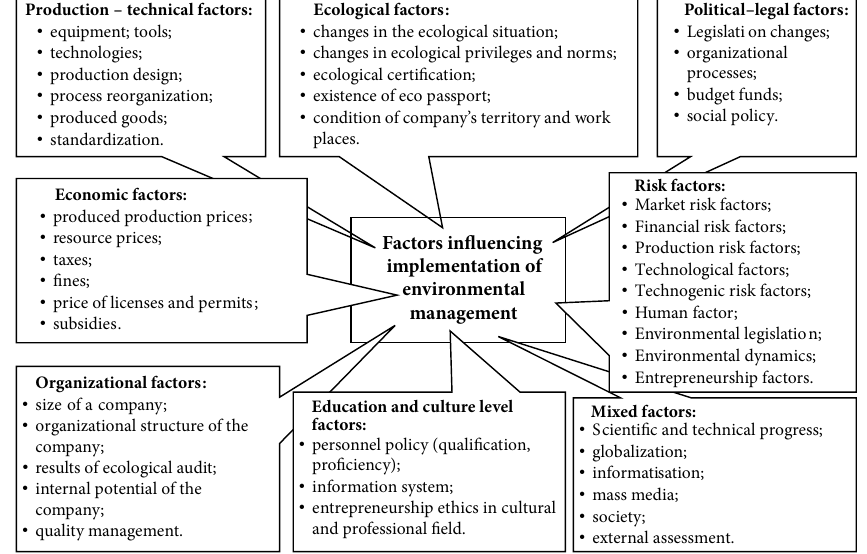
Fig. 1. Factors influencing implementation of environmental management in a company